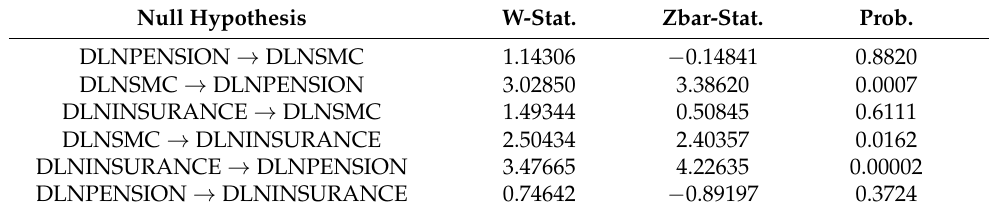
Table 6. Panel Causality Test Results. Null